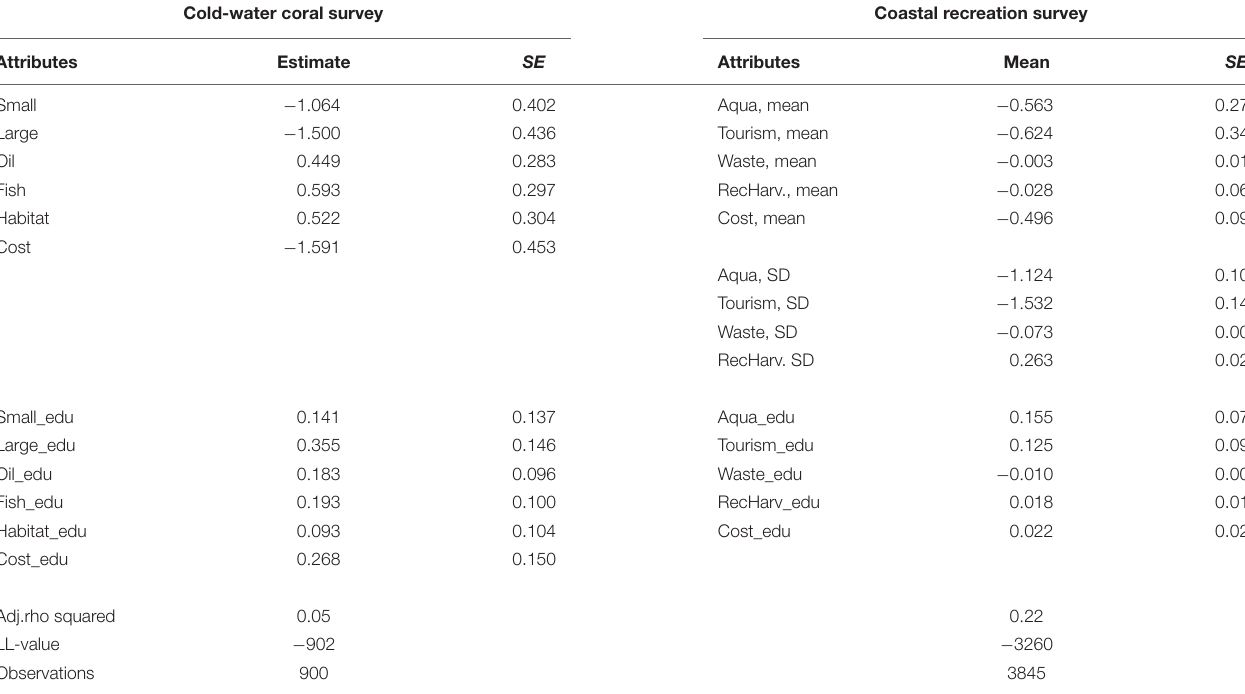
TABLE A6 | Results for model with socio-demographic interaction for education. Cold-water coral survey